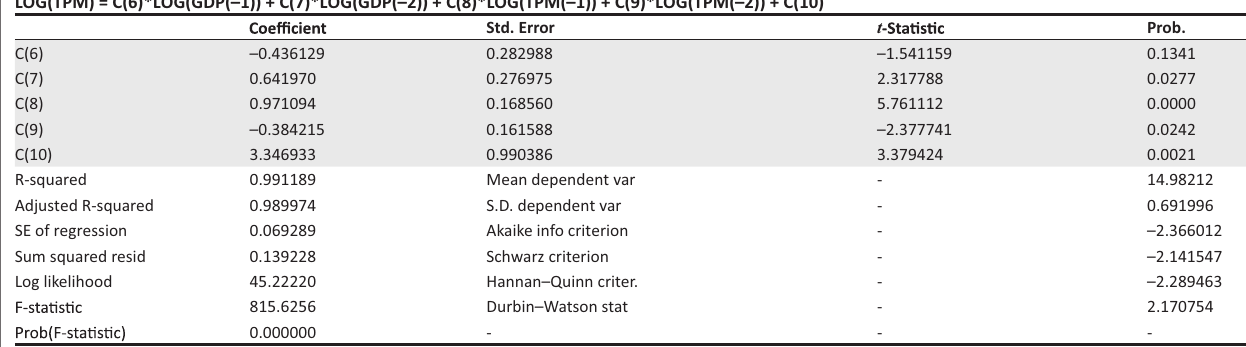
FIGURE 1-A1: Vector autoregressive model.